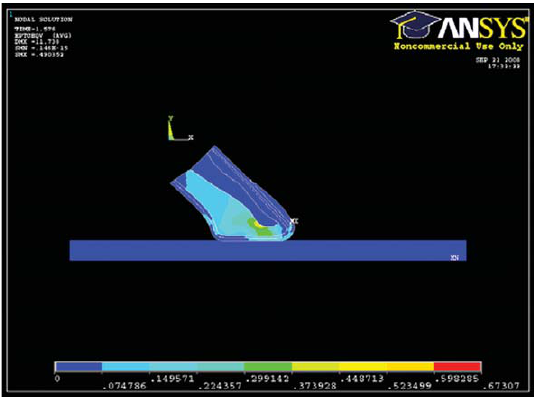
Fig. 7. The strain energy distribution during the simulation sam- pled at an arbitrary moment of proximal-to-distal movement of the fingertip on the surface.